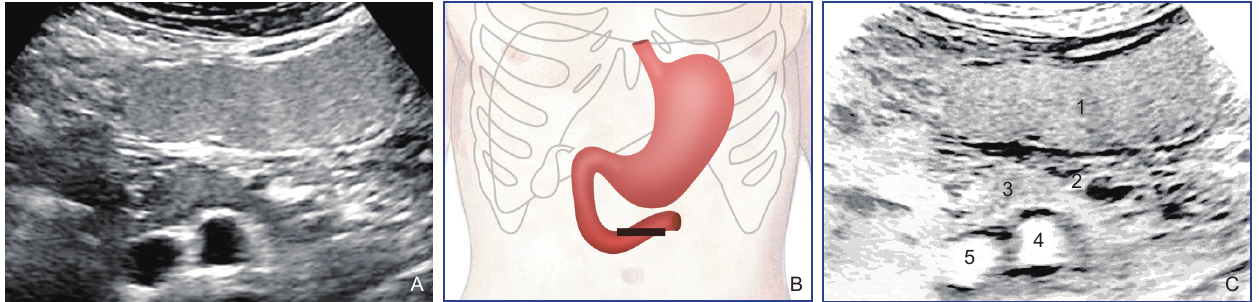
Figure 17 Ultrasonic image and scan schematic diagram of the horizontal long axis section of the duodenum (scan of the middle and upper abdomen) . A, Ultrasound image; B, Scan the schematic diagram; C, Schematic diagram of ultrasound (1. Gastric body; Superior mesenteric artery; 2. 3. Duodenal level; Abdominal aorta; 4. 5. The inferior vena